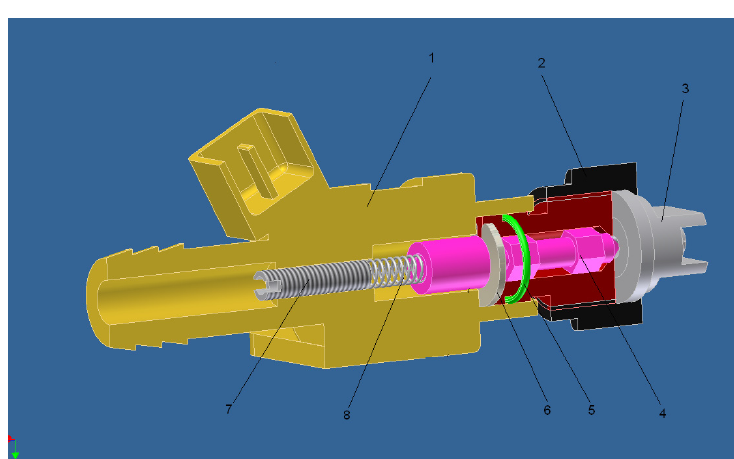
Figure 3. An electronically controlled sprayer valve, 1—body with coil, 2—nut fixing